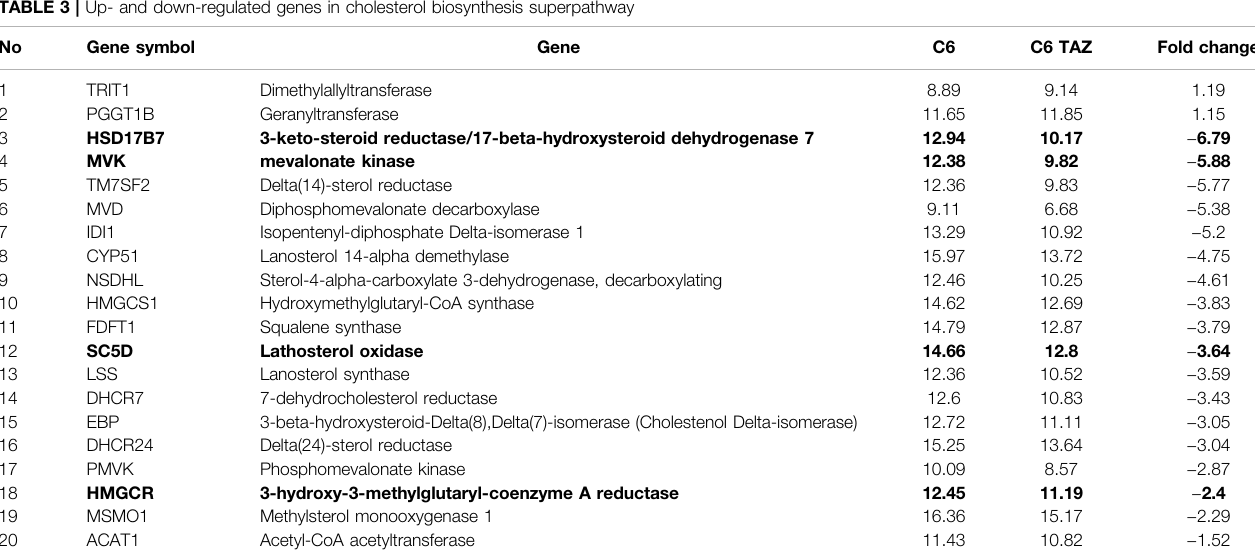
TABLE 3 | Up- and down-regulated genes in cholesterol biosynthesis superpathway